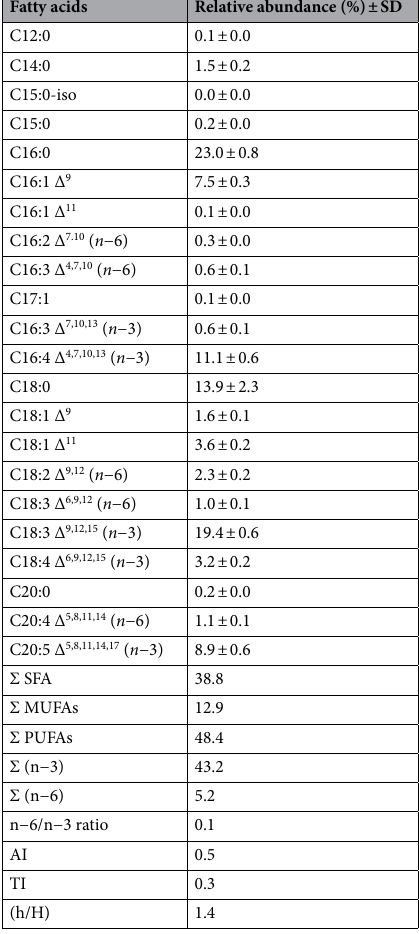
Table 1. Fatty acid profile identified in the total lipid extract of Chlorococcum amblystomatis by GC–MS. Values are expressed in relative abundance (%) and represent the mean of five analytical samples ± standard deviation (SD). SFA saturated fatty acids, MUFAs monounsaturated fatty acids, PUFAs polyunsaturated fatty acids, AI atherosclerotic index, TI thrombogenic index, (h/H) (hypocholesterolemic/hypercholesterolemic)